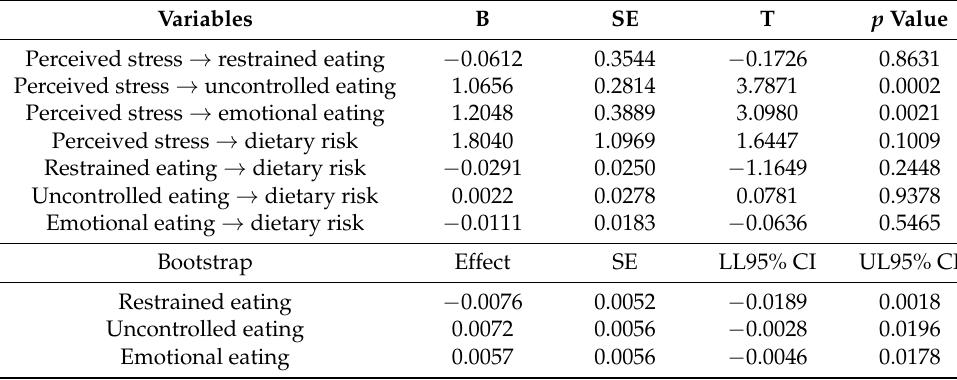
Table 7. Model 2 mediation Analysis of eating behaviors on the relationship between perceived stress and dietary risk for